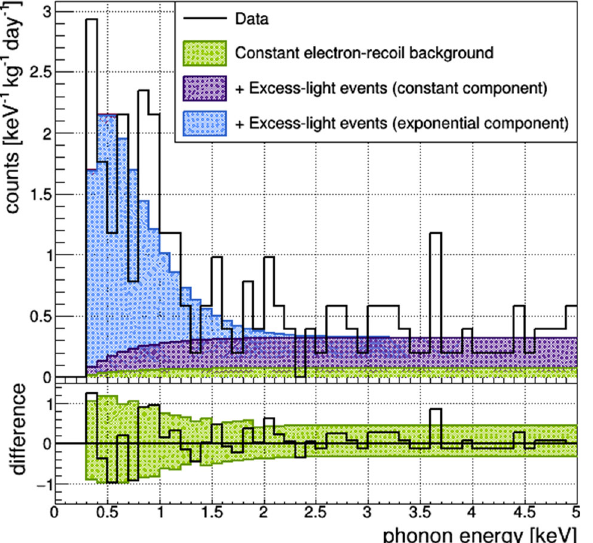
Fig. 6 Top panel Distribution of phonon energies of excess-light events. For this plot only events with light energies larger than the 99% quantile of the electron-recoil band (Eq. (8)) were taken into account. In addition, the stacked distributions of all components of the fit model are shown. The contribution by the signal is too small to be visible in this plot. The drop in the models below 2keV is related to the decreasing signal-survival probability. Bottom panel The differences between the data and the fitted model are depicted as solid black line . In addition, the statistical uncertainties (central 90% region) of the fitted model are shown as green-shaded region